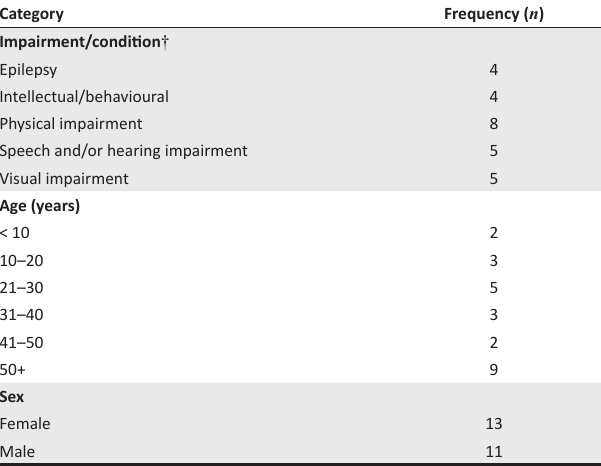
TABLE 1: Demographics of people with disabilities by impairment category † , age and sex.